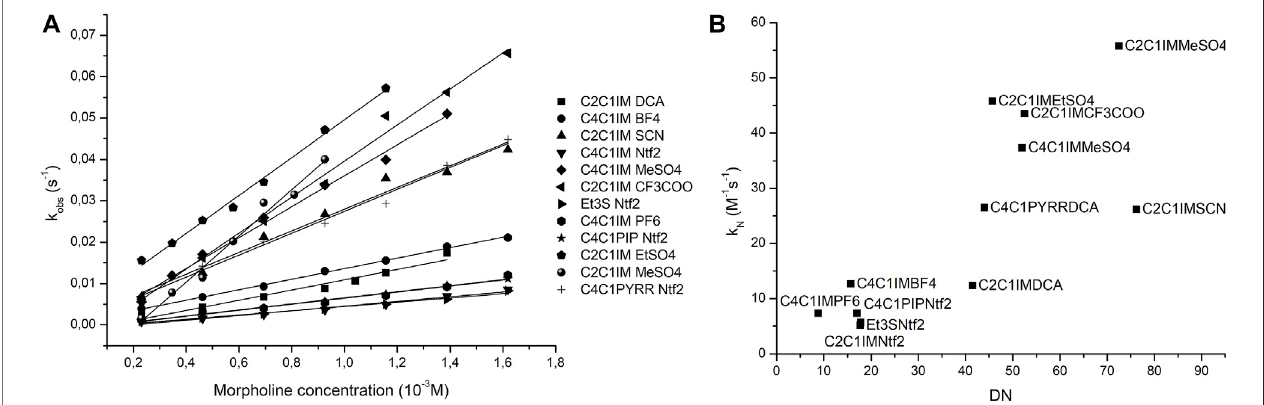
FIGURE 8 | Plots of nucleophile concentration vs. observed pseudo- fi rst-order rate (A) and donor number vs. nucleophilic reaction rate (B) .